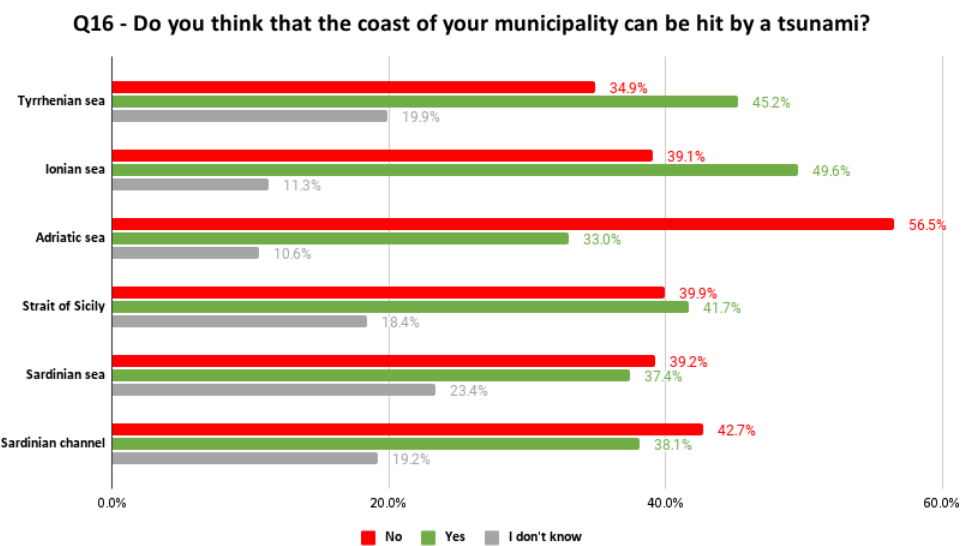
Figure 4. Q16 – tsunami risk perception in respondents’ municipalities by sea